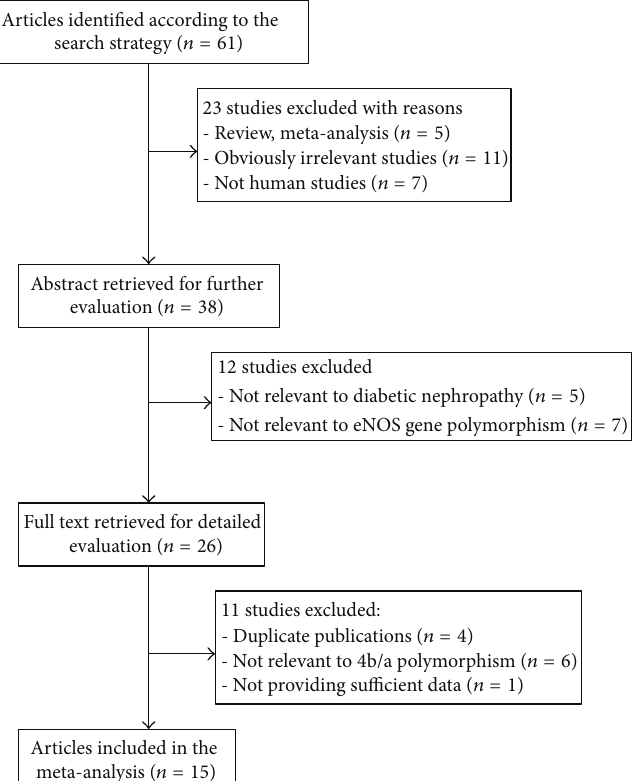
Figure 1: Flow chart of included studies.